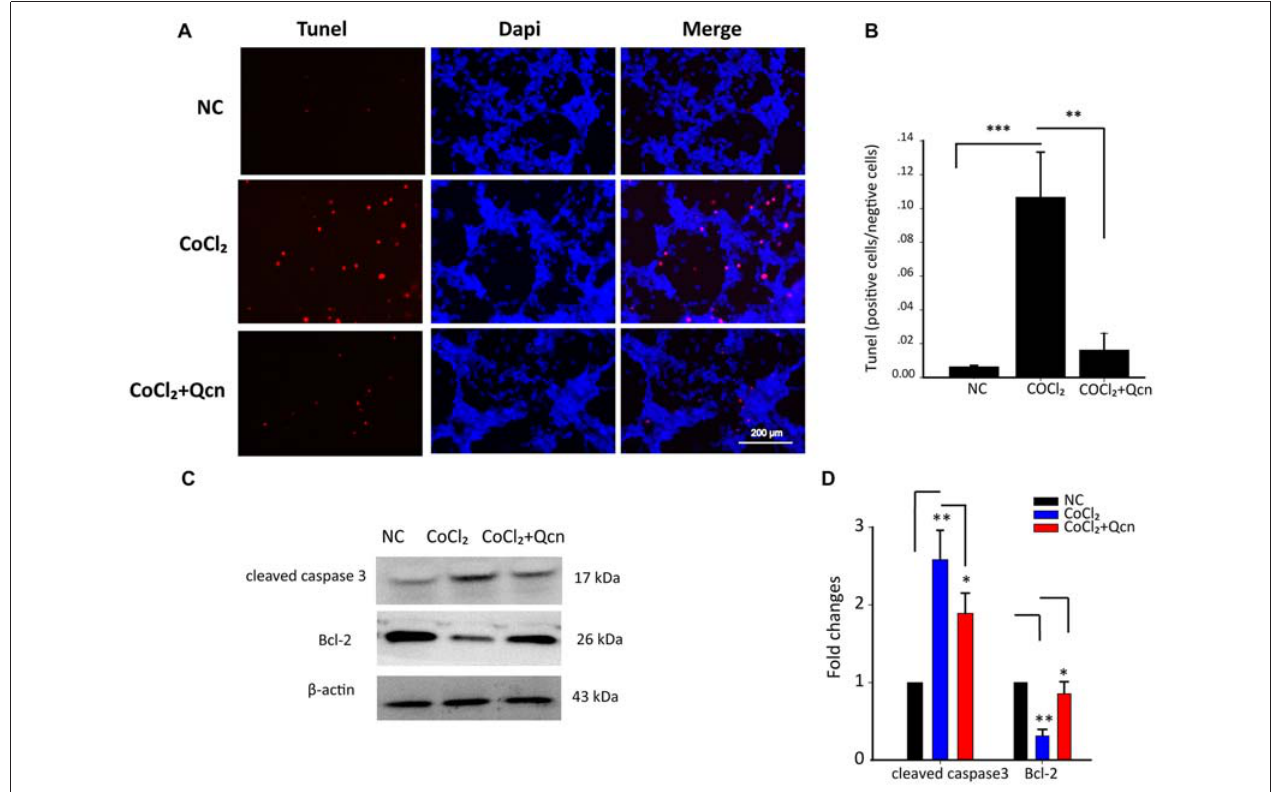
FIGURE 7 | (A) TUNEL analysis of RGCs from the following three different groups: NC group, CoCl 2 -treatment group (48 h) and CoCl 2 with Qcn-treatment group (48 h). Red indicates TUNEL-positive cells, and blue indicates DAPI. All images were captured at the same magnification. Scale bar, 200 µ m. (B) Quantitative analysis of TUNEL-positive cells in retinas from different treatment groups. The data are presented as the mean ± SD; ∗∗ p < 0.01 and ∗∗∗ p < 0.001. (C,D) Expression of cleaved caspase-3 and Bcl-2 detected by Western blot in RGCs from the following three treatment groups: NC group, CoCl 2 -treatment group (48 h) and CoCl 2 with Qcn-treatment group (48 h). The bars indicate the mean ± SD. β -actin was used as an internal control. ∗ p < 0.05 and ∗∗ p <